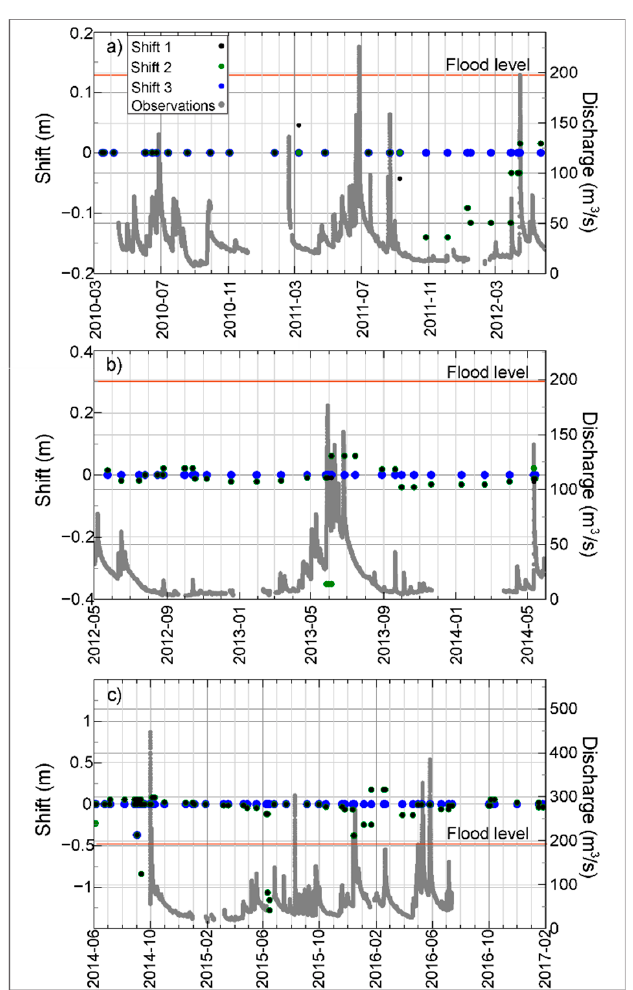
Figure 11. Shift values plotted with hydrograph data in West Nishnabotna River near Riverton Black, green, and blue dots represent the shift values applied to the section, channel, and overbank control areas, respectively. ( a ) Hydrograph for base rating curve #1.0; ( b ) hydrograph for base rating curve #1.1; and ( c ) hydrograph for base rating curve #2.0.